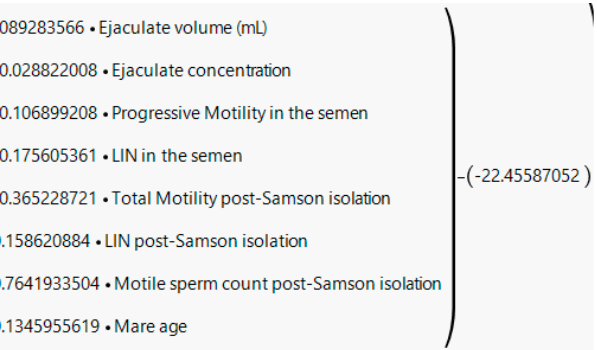
Figure A2. Equation optimized for stallion 1 from the pre-chilled data set: predictive accuracy of 80%.